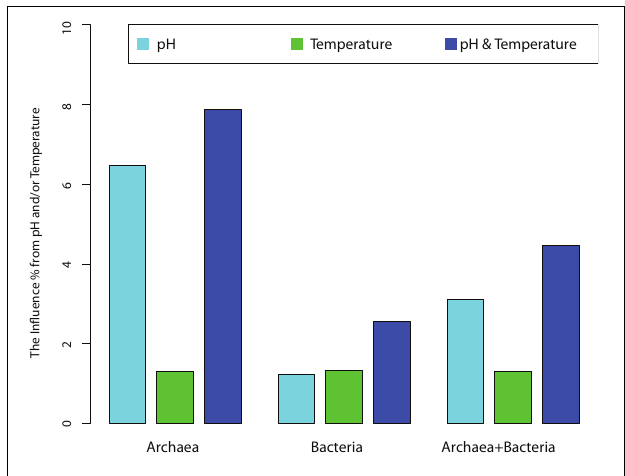
FIGURE 4 | The variance of community changes explained by the environmental factors (pH, temperatures, and their joint